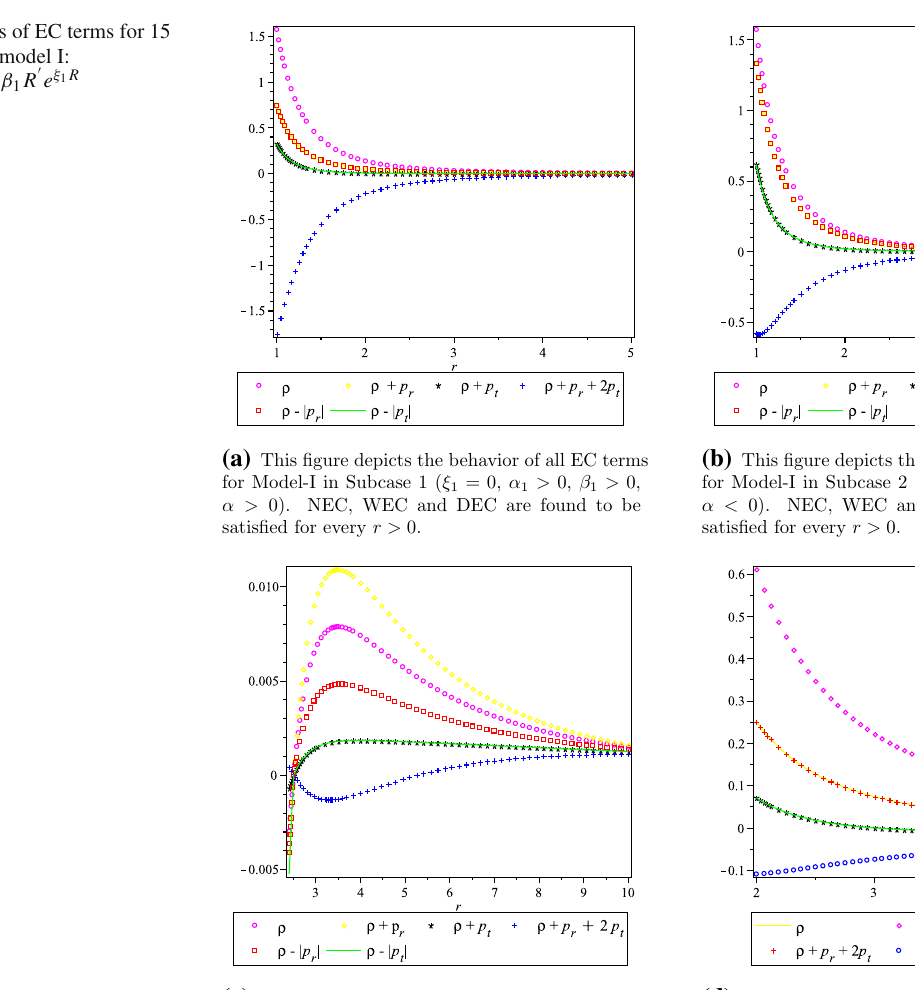
(c) This figure shows the nature of all EC terms for Model-I in Subcase 4 ( ξ 1 = 0, α 1 < 0, β 1 < 0, α < 0). Except SEC, all ECs are found to be satisfied for every r > 0.